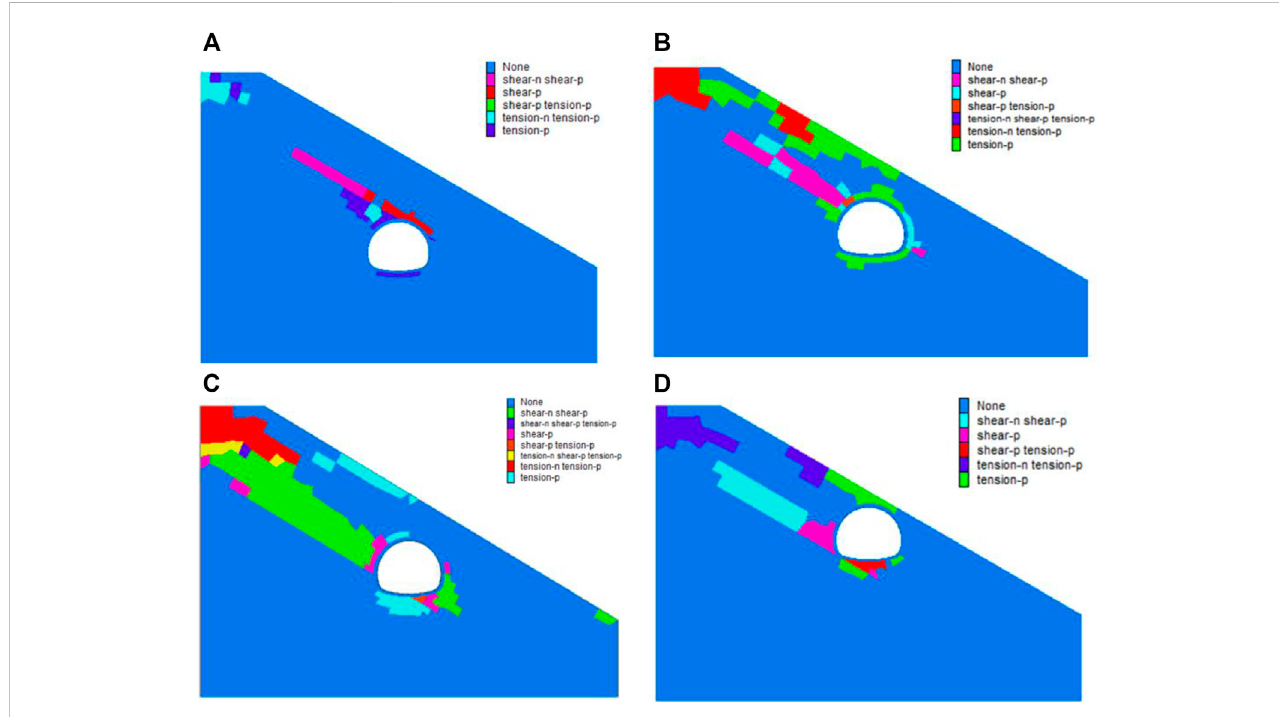
FIGURE 18 Plasticzoneofsurroundingrockunderfourdifferentconditions: (A) Tunnelvaultcrossingthesoil – rockinterface; (B) Archhaunchcrossingthesoil – rock interface; (C) Arch spring crossing the soil – rock interface; and (D) Wall foot crossing the soil – rock